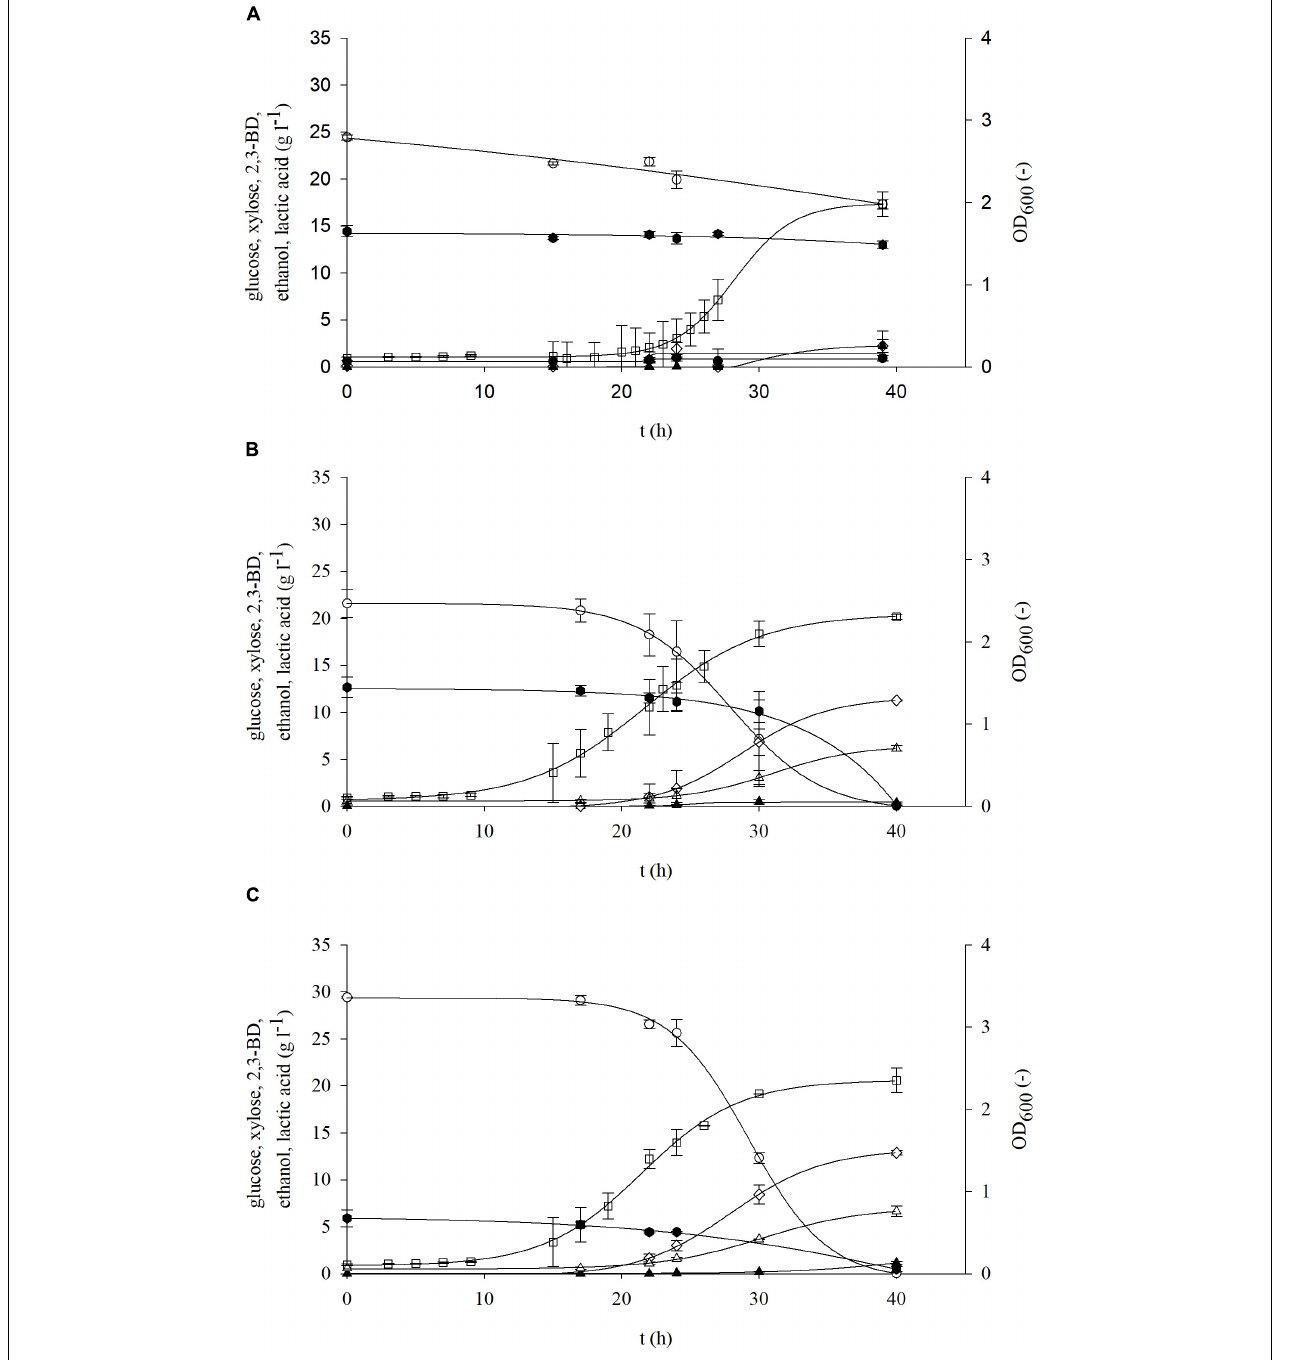
FIGURE 4 | Changes in optical density (OD 600 , (cid:3) ) and concentration of glucose ( (cid:13) ), xylose ( ), 2,3-BD ( (cid:5) ), lactate ( (cid:78) ), and ethanol ( (cid:52) ) during cultivation of bacterium P. polymyxa DSM 742 in media with different initial glucose and xylose concentrations [ (A) 27 g l − 1 glucose and 12 g l − 1 xylose; (B) 22 g l − 1 glucose and 10 g l − 1 xylose; (C) 33 g l − 1 glucose and 4 g l − 1 xylose].